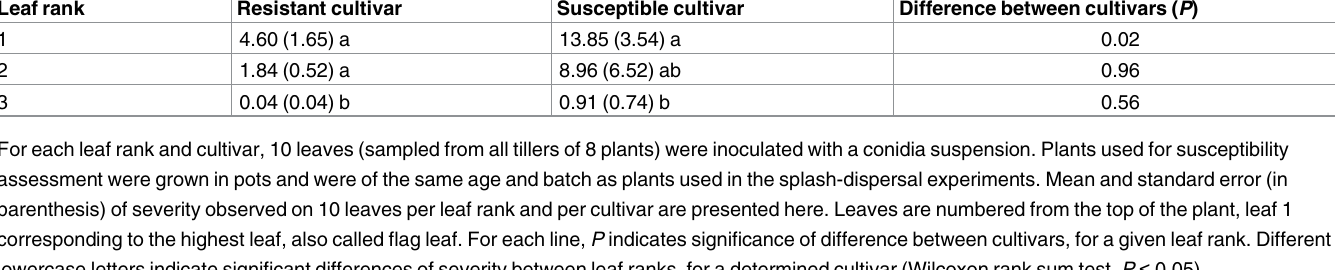
Table 1. Assessment of the susceptibility of two wheat cultivars through leaf severity (% sporulating area) with non limiting inoculum of Zymosep- toria tritici conidia and optimal infection conditions. Leaf rank Resistant